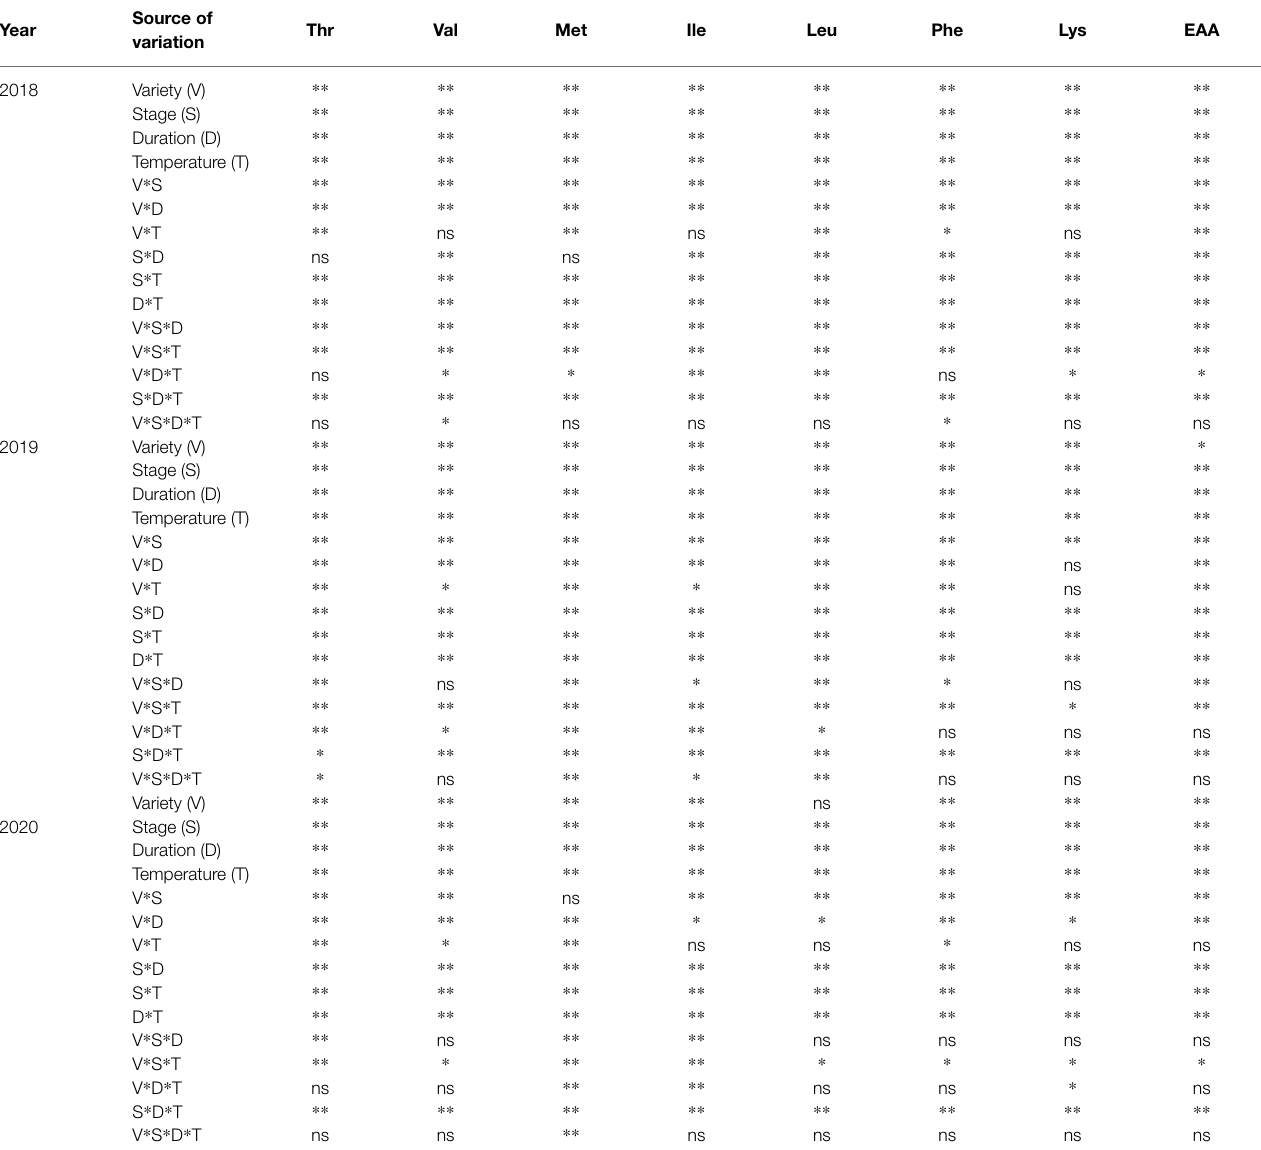
TABLE 3 | ANOVA results for the accumulation of essential amino acids under low-temperature treatments. Source of Year